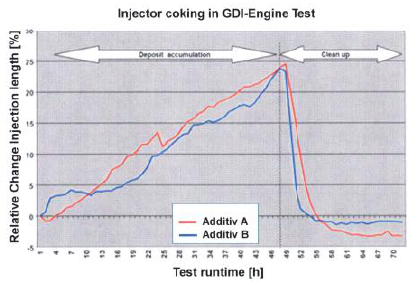
Fig. 2. Typical run of "Keep-Clean" and "Dirty-Up" & Clean-Up" tests (one fuel and two different DCA additives) [19]